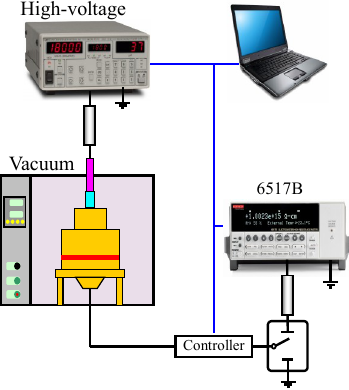
Figure 1. Conductivity test schematic.